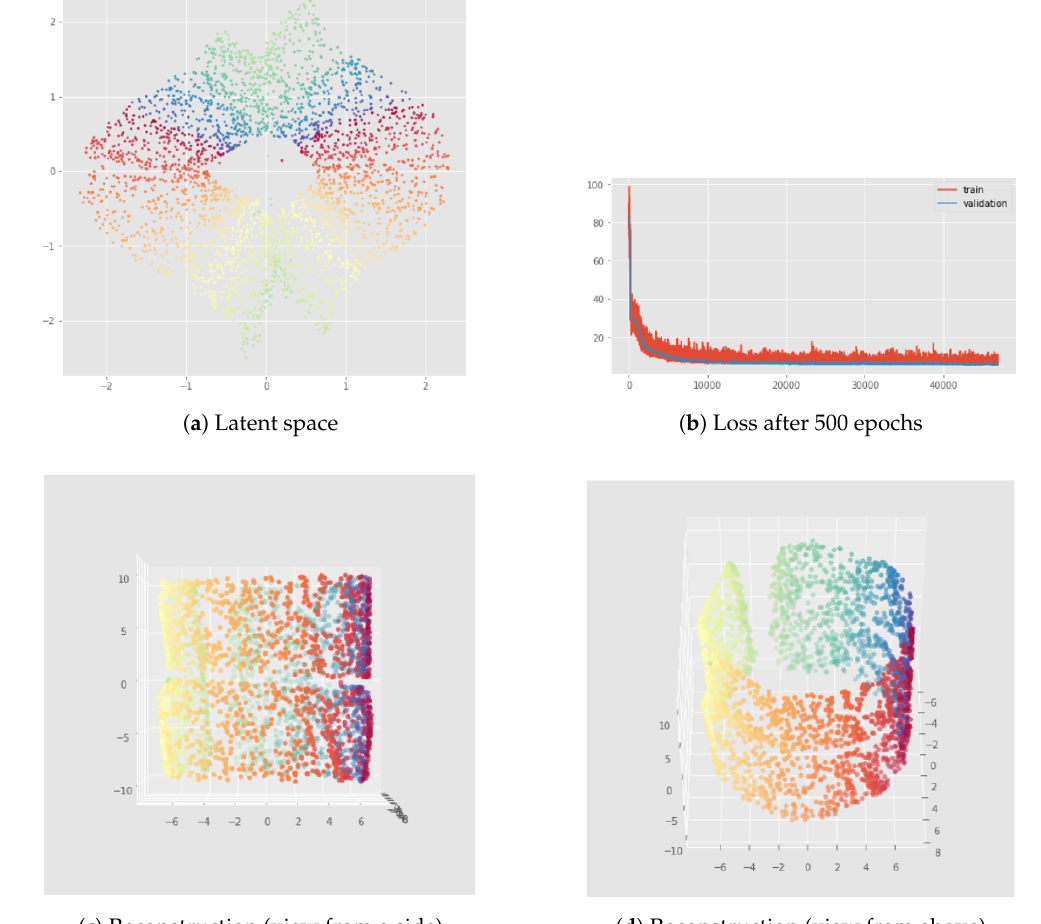
Figure 11. Latent representation (top left) and reconstruction (down) of the Standard VAE applied to the open cylinder, trained for 500 epochs. We can see again that for the latent representation ( a ) we have β 1 = 1 like to the original open cylinder dataset. However, the latent representation is bad because the “color order” is not preserved so this latent representation would not be useful for interpolations, it is like dividing the cylinder in top and down regions. Indeed, we can see in ( c ) that this implies a discontinuity between top part and down part for example with the orange region. In addition to that, we have also a longitudinal discontinuity in the green region as shown in ( d